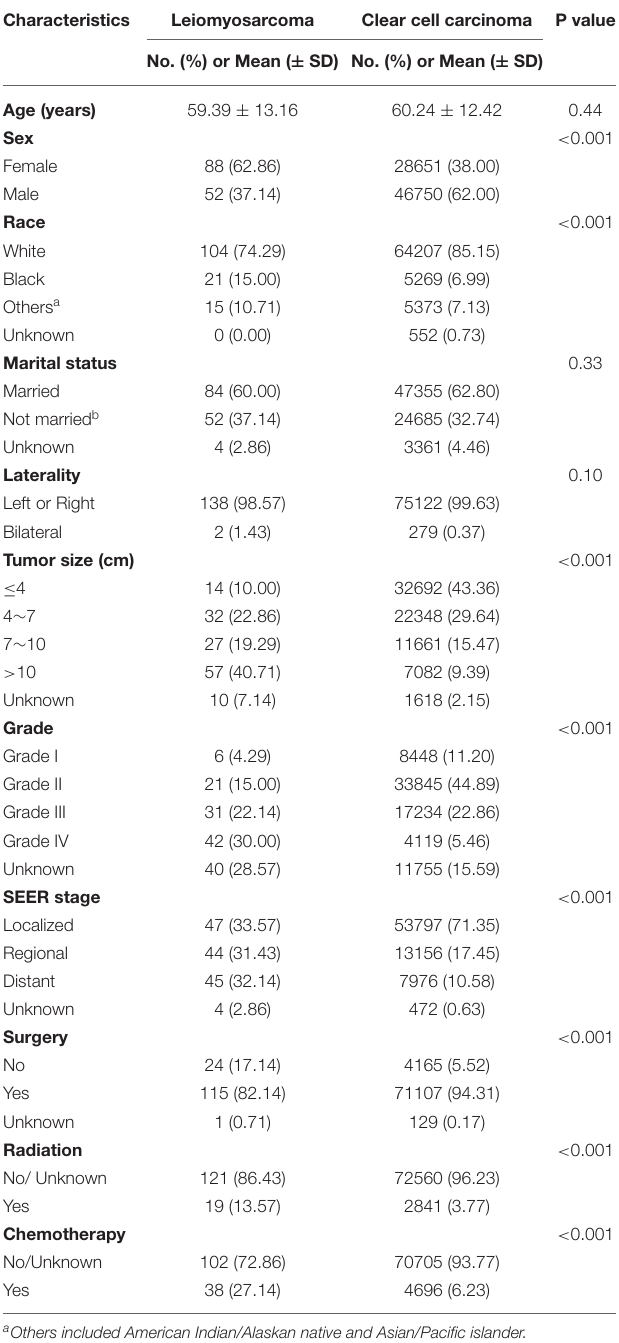
TABLE 1 | Clinicopathological characteristics of the patients with primary renal leiomyosarcoma and kidney renal clear cell carcinoma. Characteristics